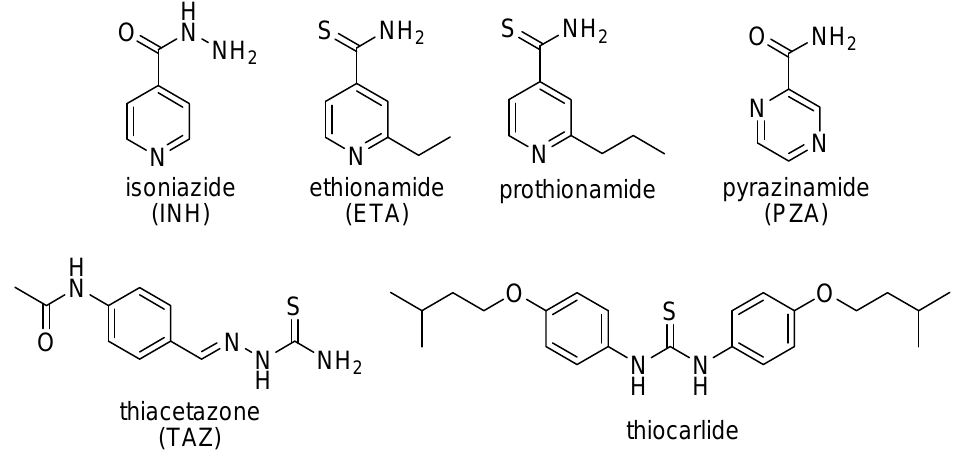
Figure 33. Chemical structures of some antimycobacterial